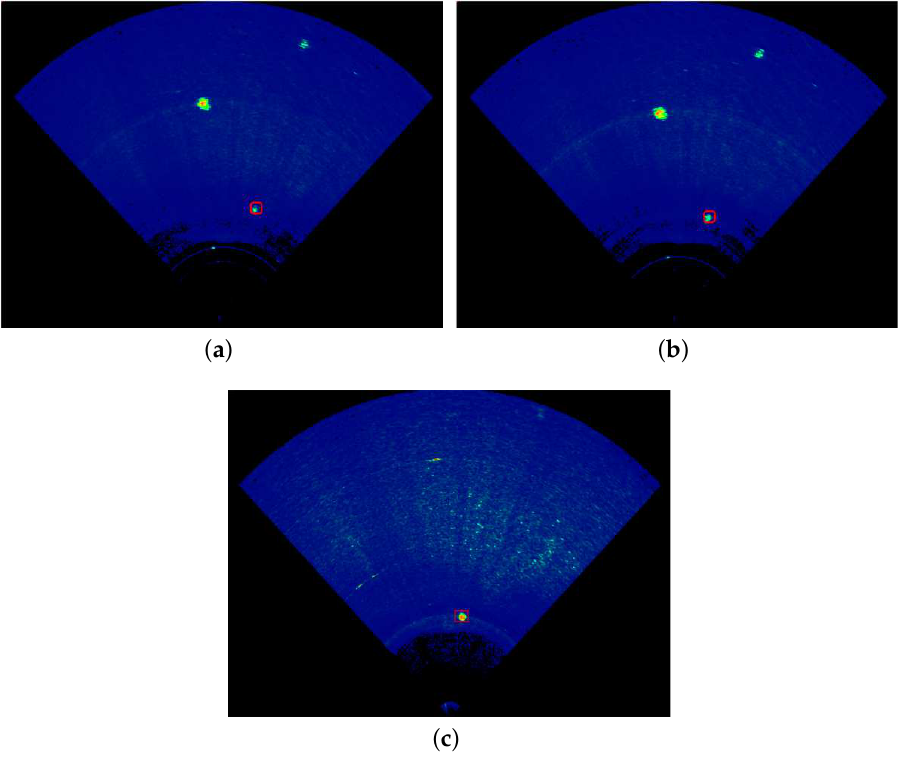
Figure 1. Tracking results at different times: ( a ) The tracking results at the 6th frame; ( b ) the tracking results at the 12th frame; ( c ) the tracking results at the 31st frame.